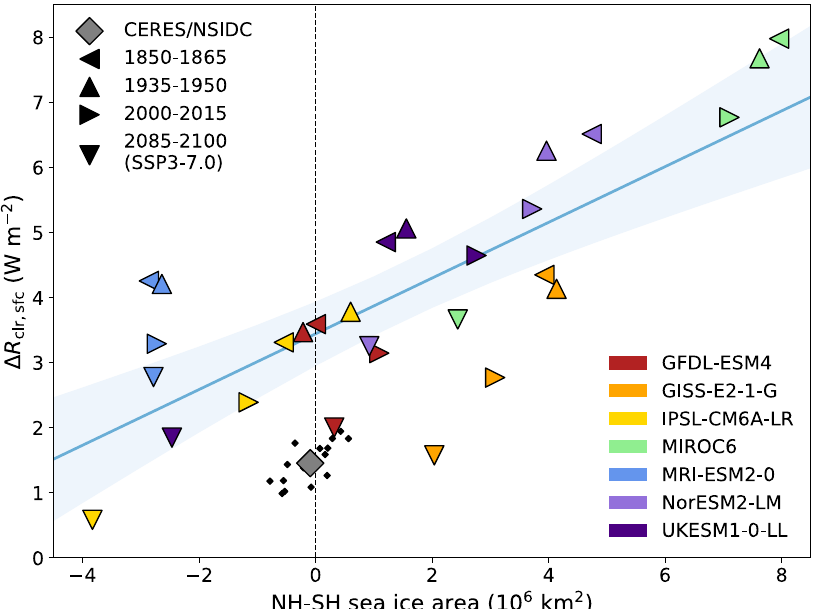
Fig. 5 Relationship between the hemispheric sea ice and surface re fl ection asymmetries in the preindustrial, midcentury, present-day, and high- emissions future. CMIP6 model values of hemispheric asymmetries (NH-SH) in sea ice area and clear-sky atmospheric re fl ection ( Δ R clr,sfc ) from the historical and SSP3-7.0 runs are represented as colored triangles (facing left for the 1850 – 1865 mean, up for 1935 – 1950, right for 2000 – 2015, down for 2085 – 2100; red for GFDL-ESM4, orange for GISS-E2-1-G, yellow for IPSL-CM6A-LR, green for MIROC6, blue for MRI-ESM2-0, indigo for NorESM2-LM, and violet for UKESM1-0-LL) and their regression fi t and its 95% con fi dence interval are represented by the blue line and shading. CERES/National Snow and Ice Data Center (NSIDC) data are represented as a gray diamond for the modern mean and as smaller black diamonds for individual